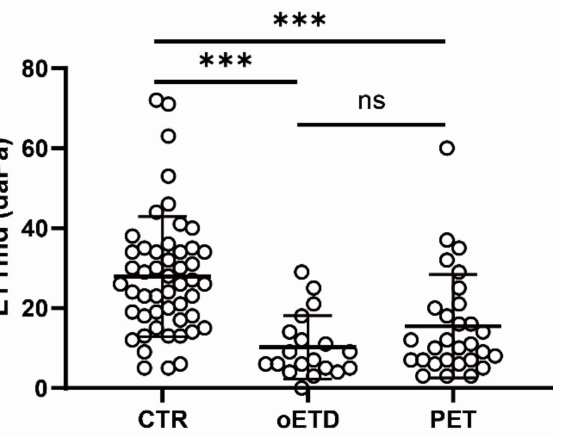
Figure 1. Eustachian tube function of the three groups. ETTmd: maximal difference of peak